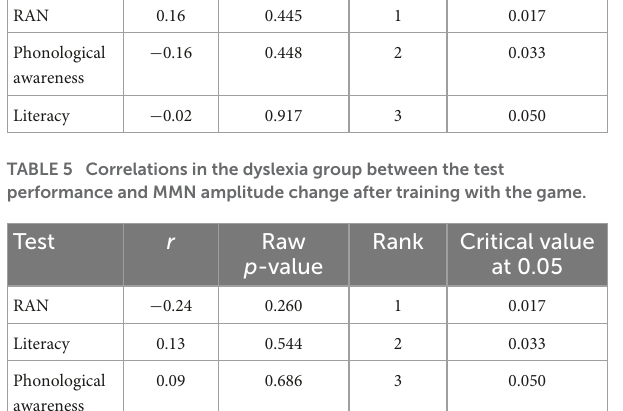
TABLE 4 Correlations in the control group between the test performance and MMN amplitude change after training with the non-game. Test Raw Rank Critical value p -value at 0.05